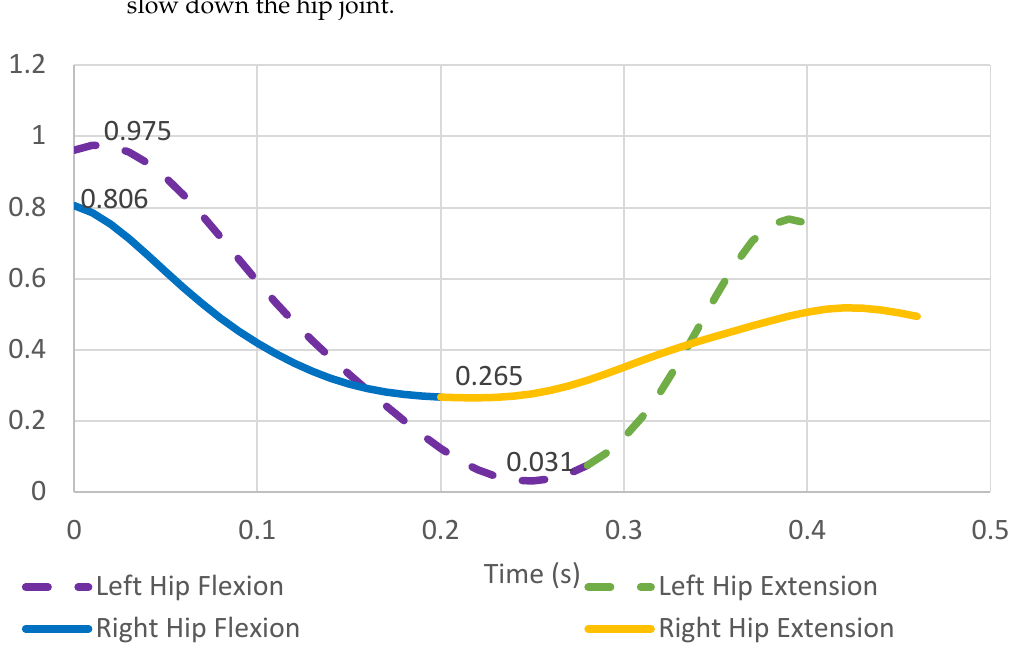
Figure 5. Hip joint moment during discrete isolated kicks for right and left hips.